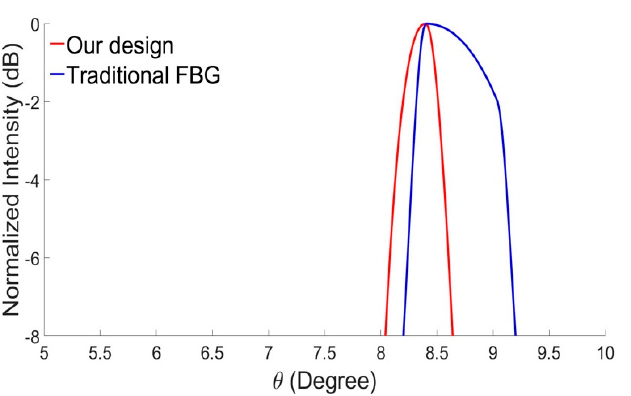
Figure 7. The FFP intensity is calculated using FDTD for 32 antennas. ( a ) The OPA main beams of a conventional single- width combination without a SR grating. ( b ) The primary beam intensity of a chirped FBG built with SR in OPA steer- ing.